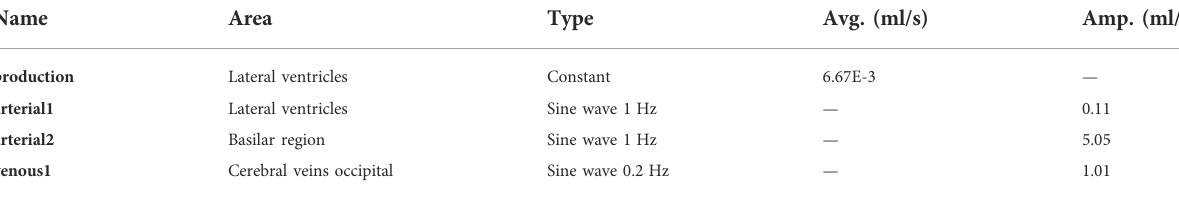
TABLE 1 Overview of average values (avg.) and amplitudes (amp.) of all the inlet boundary